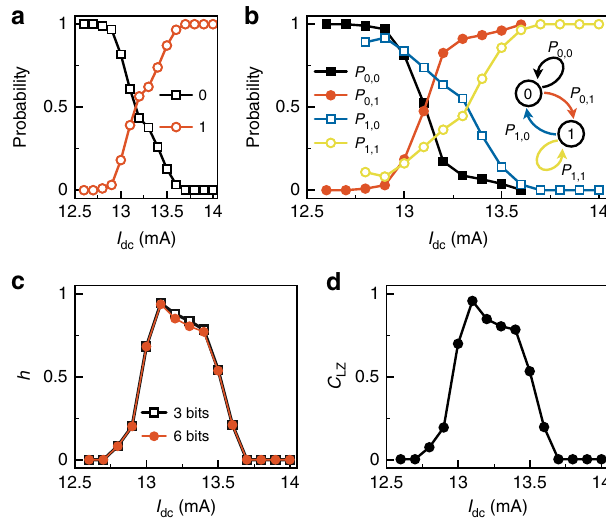
Fig. 4 Complexity and control of bit sequences. a Probability of 0 and 1 in the generated bit sequences as a function of I . b Probability of moving dc from the current state, i , to the next state, j , P i ; j . The inset shows the Markov chain for a 1 bit information. c Shannon block entropy rate, h , as a function of I for different block lengths, 3 bits and 6 bits. d Normalized Lempel – Ziv dc complexity, C , as a function of I LZ dc